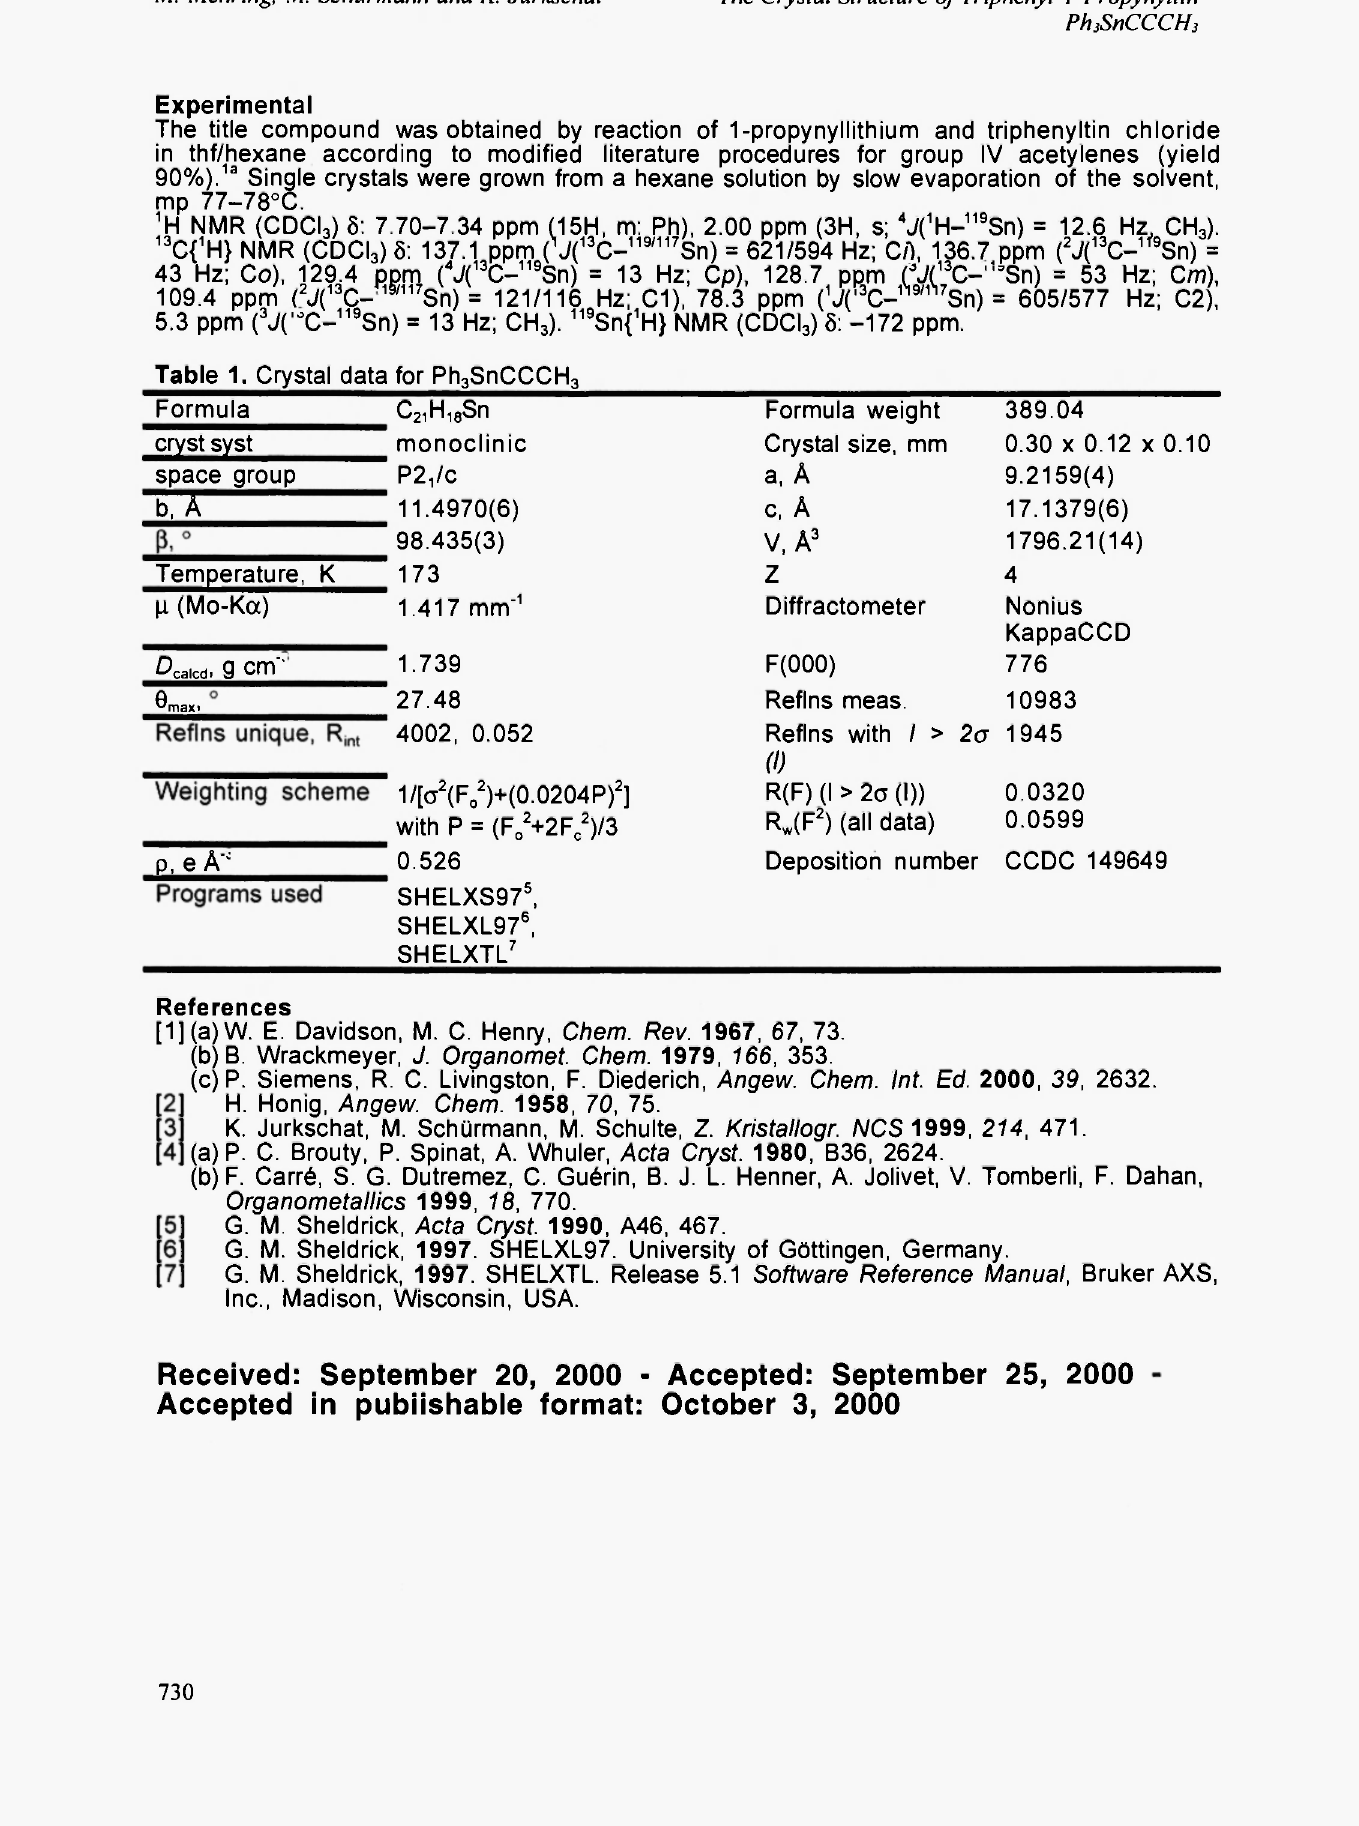
Table 1. Crystal data for Ph 3 SnCCCH